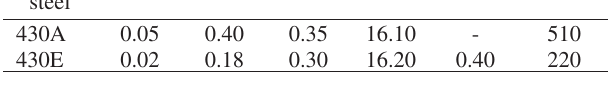
Table 1. Chemical composition of the 430A and 430E Stainless Steels (wt. (%)). Stainless